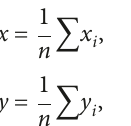
=0.04 – 0.08MPa and (b) P t3